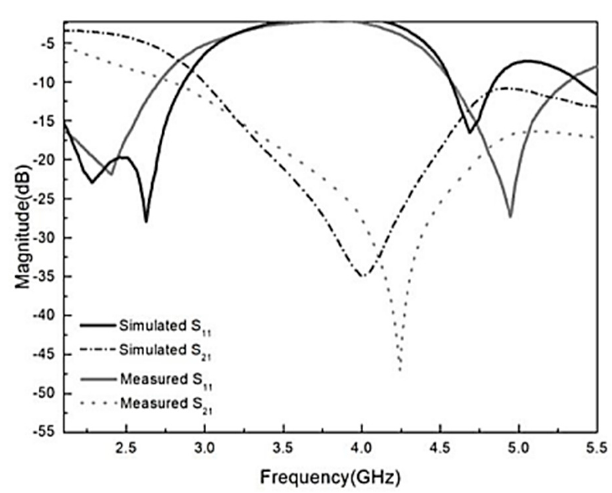
Figure 4. Comparative results between simulation and measurement S-parameter responses of the transmission line loaded with four SRRs.